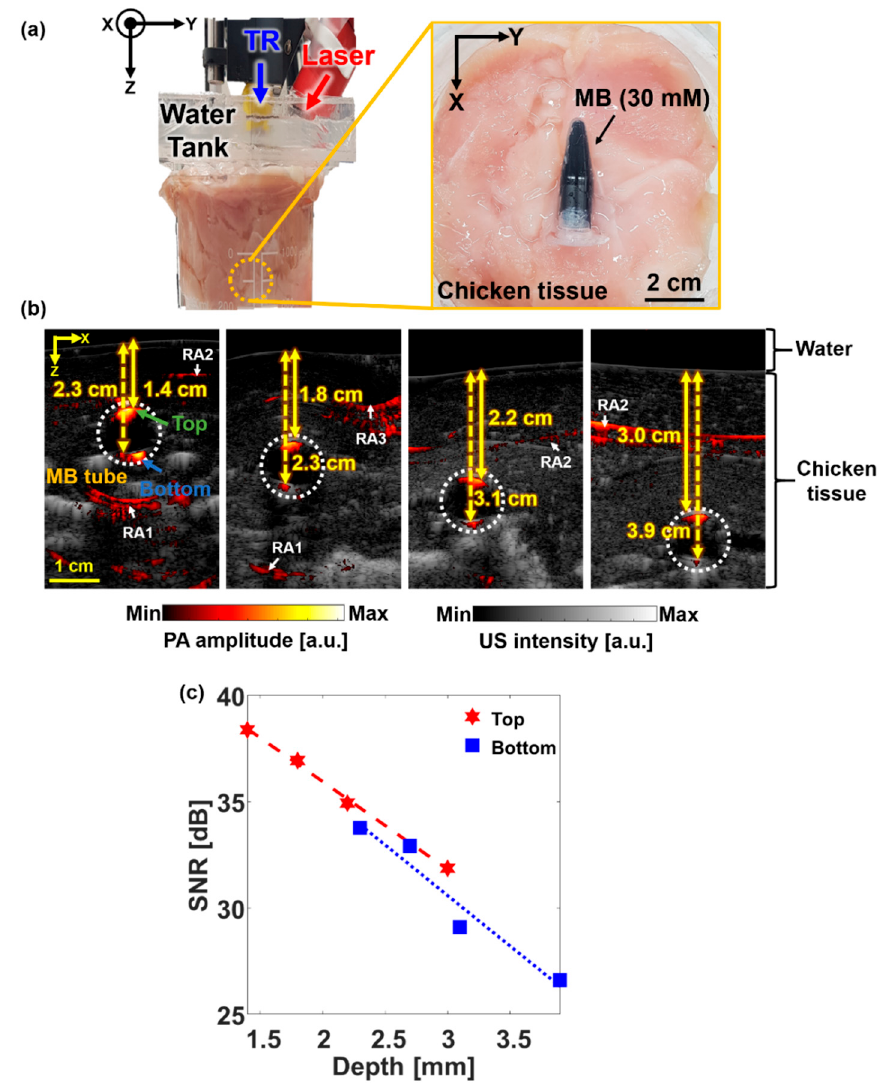
Figure 3. In vitro PA imaging of the MB tube at different depths. ( a ) Photographs of the experimental setup and the MB containing the tube positioned in chicken tissue. ( b ) Overlaid B-mode PA/US images at different depths. ( c ) SNRs of the PA images of 30-mM MB-filled tube at various depths from the tissue surface at 650-nm wavelength. TR, transducer; MB, methylene blue; SNR, signal-to-noise ratio; PA, photoacoustic; US, ultrasound; RA, reflection artifact; and a.u., arbitrary unit.